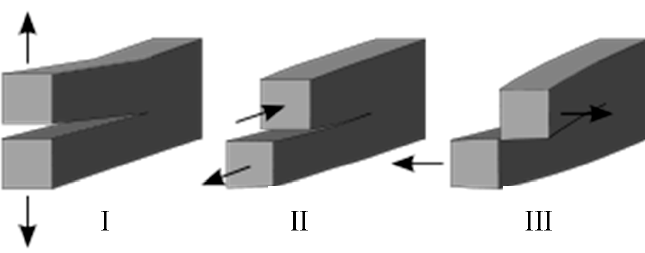
Figure 10. Crack Mode I, Mode II, and Mode III.